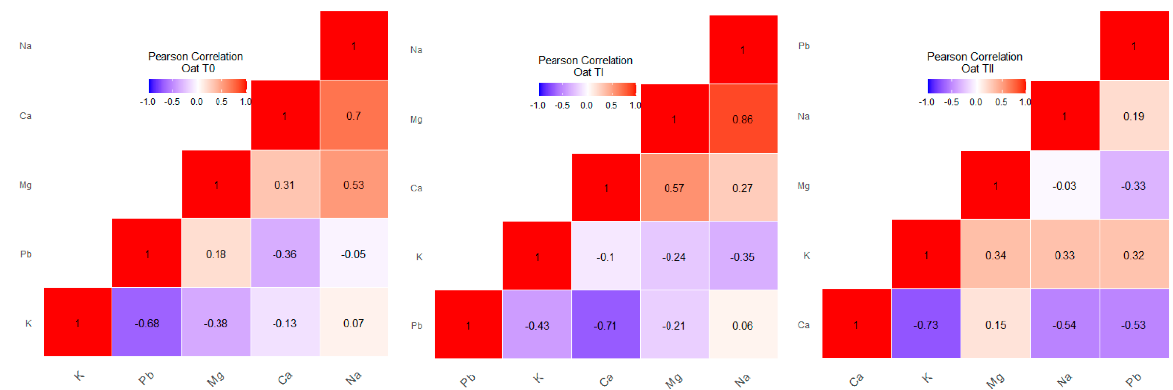
Figure 5. Heat map for Pearson’s correlation coefficients between Ca, K, Mg, Na and Pb for plants. (lupine, camelina and oat) for different treatments (T0, TI, TII).